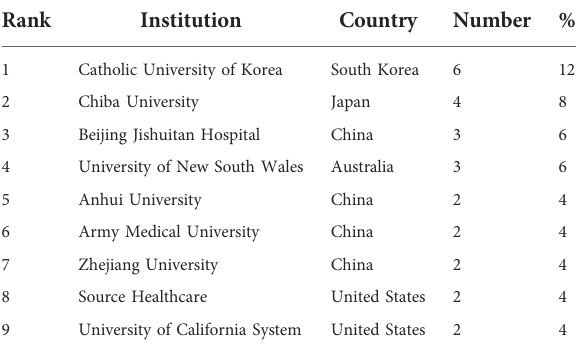
TABLE 2 Contributing institution of the 50 most cited articles on pre- psoas oblique lumbar interbody fusion. Rank